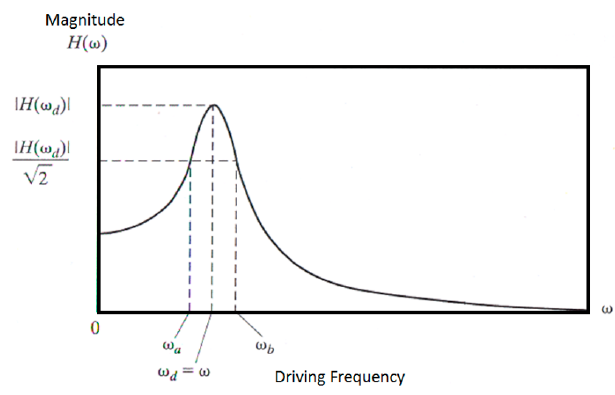
Figure 13. Quadrature peak picking method. Table 2. Natural frequency and damping ratio of each peak.